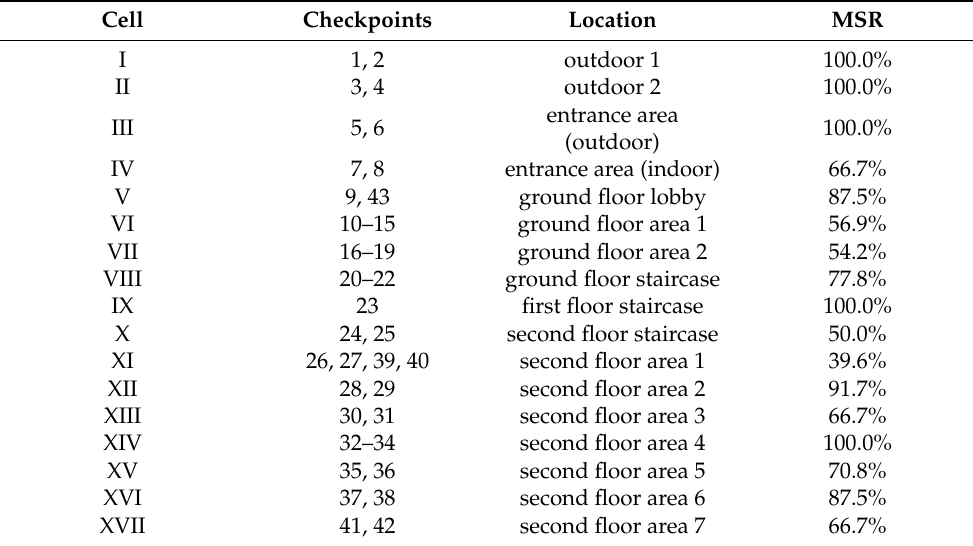
Table 7. Matching success rates (MSR) in the cells in the library (for the location of the cells see Figure